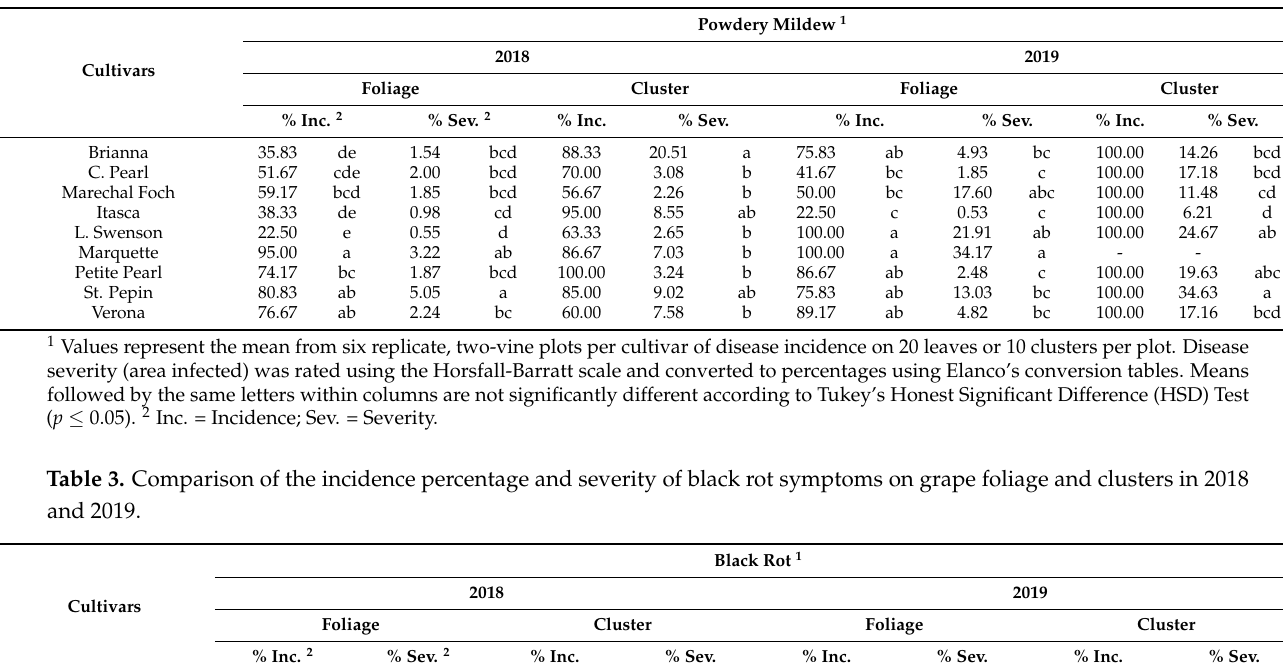
Table 2. Comparison of the incidence percentage and severity of powdery mildew symptoms on grape foliage and clusters in 2018 and 2019.